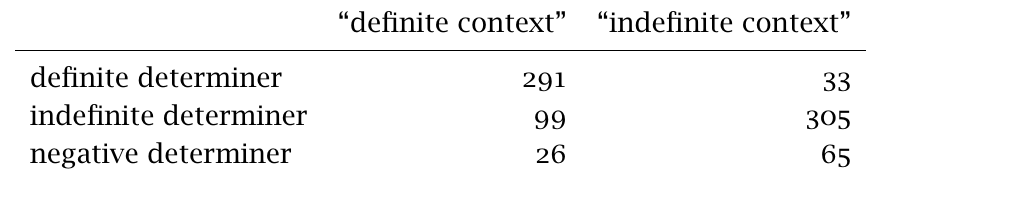
Response frequencies in the forced choice